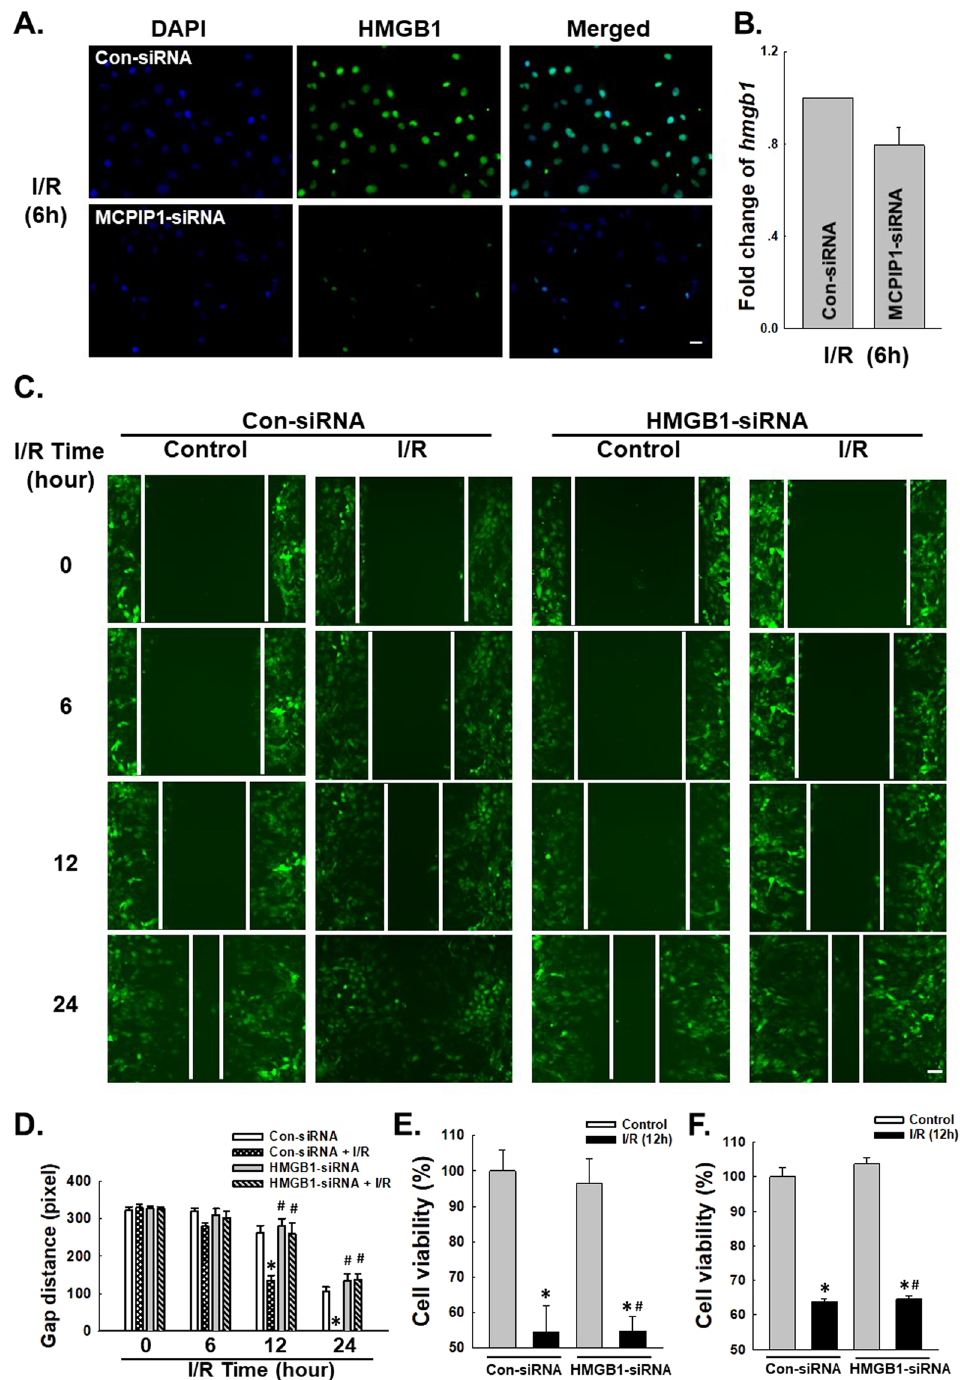
Figure 2. HMGB1 is involved in I/R-induced HUVEC migration but not apoptosis. ( A ) Representative images of immunocytochemical staining showing that I/R-induced HMGB1 expression was attenuated by MCPIP1 siRNA in HUVECs. Scale bar, 20 μ m. ( B ) Results from quantitative RT-PCR demonstrating that the expression of hmgb1 mRNA was not affected by MCPIP1 siRNA treatment in HUVEC cells, n = 3. ( C ) Representative images showing that the I/R-induced migration of HUVECs grown in monolayer cultures was abolished by HMGB1 siRNA. Scale bar, 80 μ m. ( D ) The quantification of the scratch gap distance in six independent experiments is presented. * p < 0.05 compared with the control group. ( E ) MTT assay showing the effect of HMGB1 siRNA on cell viability following I/R treatment. * p < 0.05 compared with the control group, # p < 0.05 compared with the I/R group. ( F ) CCK8 assay showing the effect of HMGB1 siRNA on cell viability following I/R treatment. * p < 0.05 compared with the control group, # p < 0.05 compared with the I/R